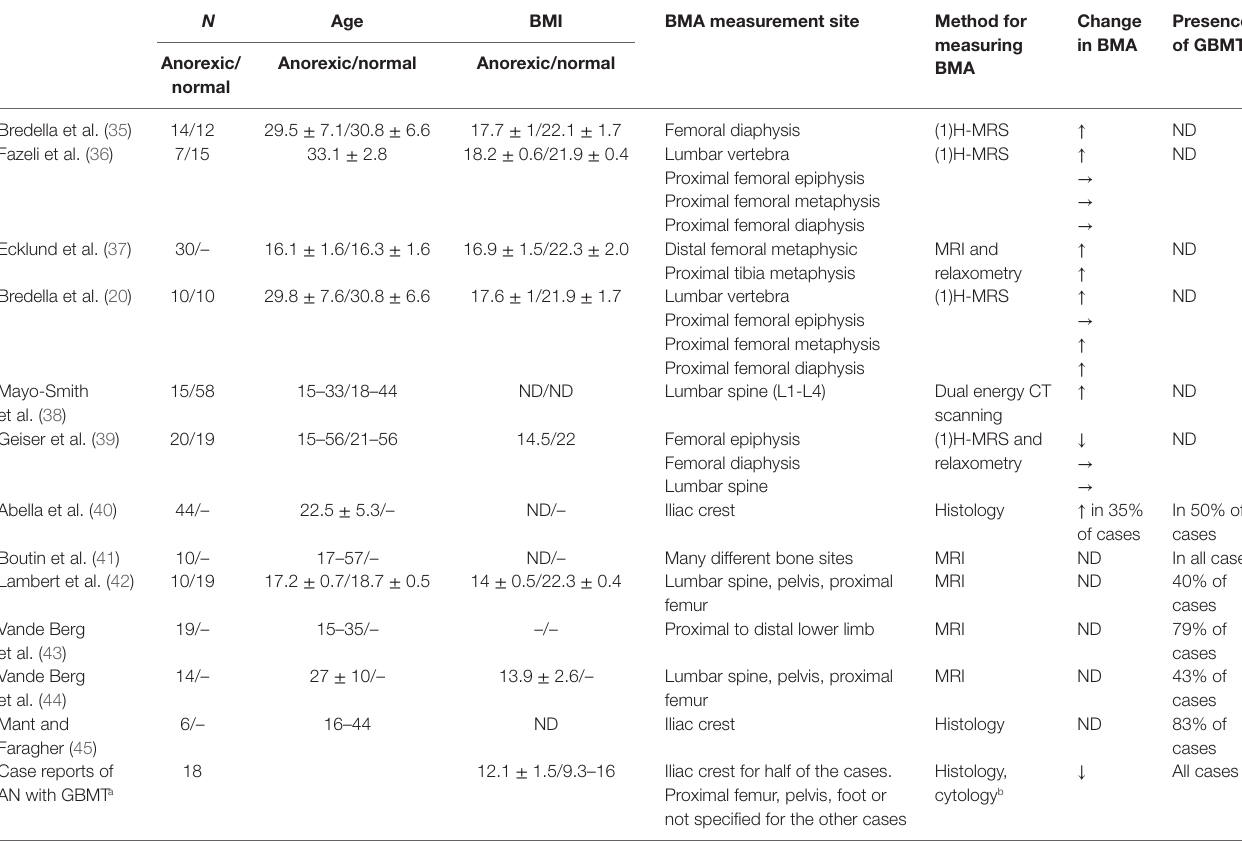
tABle 1 | variations in BMA and the presence of gelatinous BM transformation in patients with AN, as reported in case–control studies and case reports.